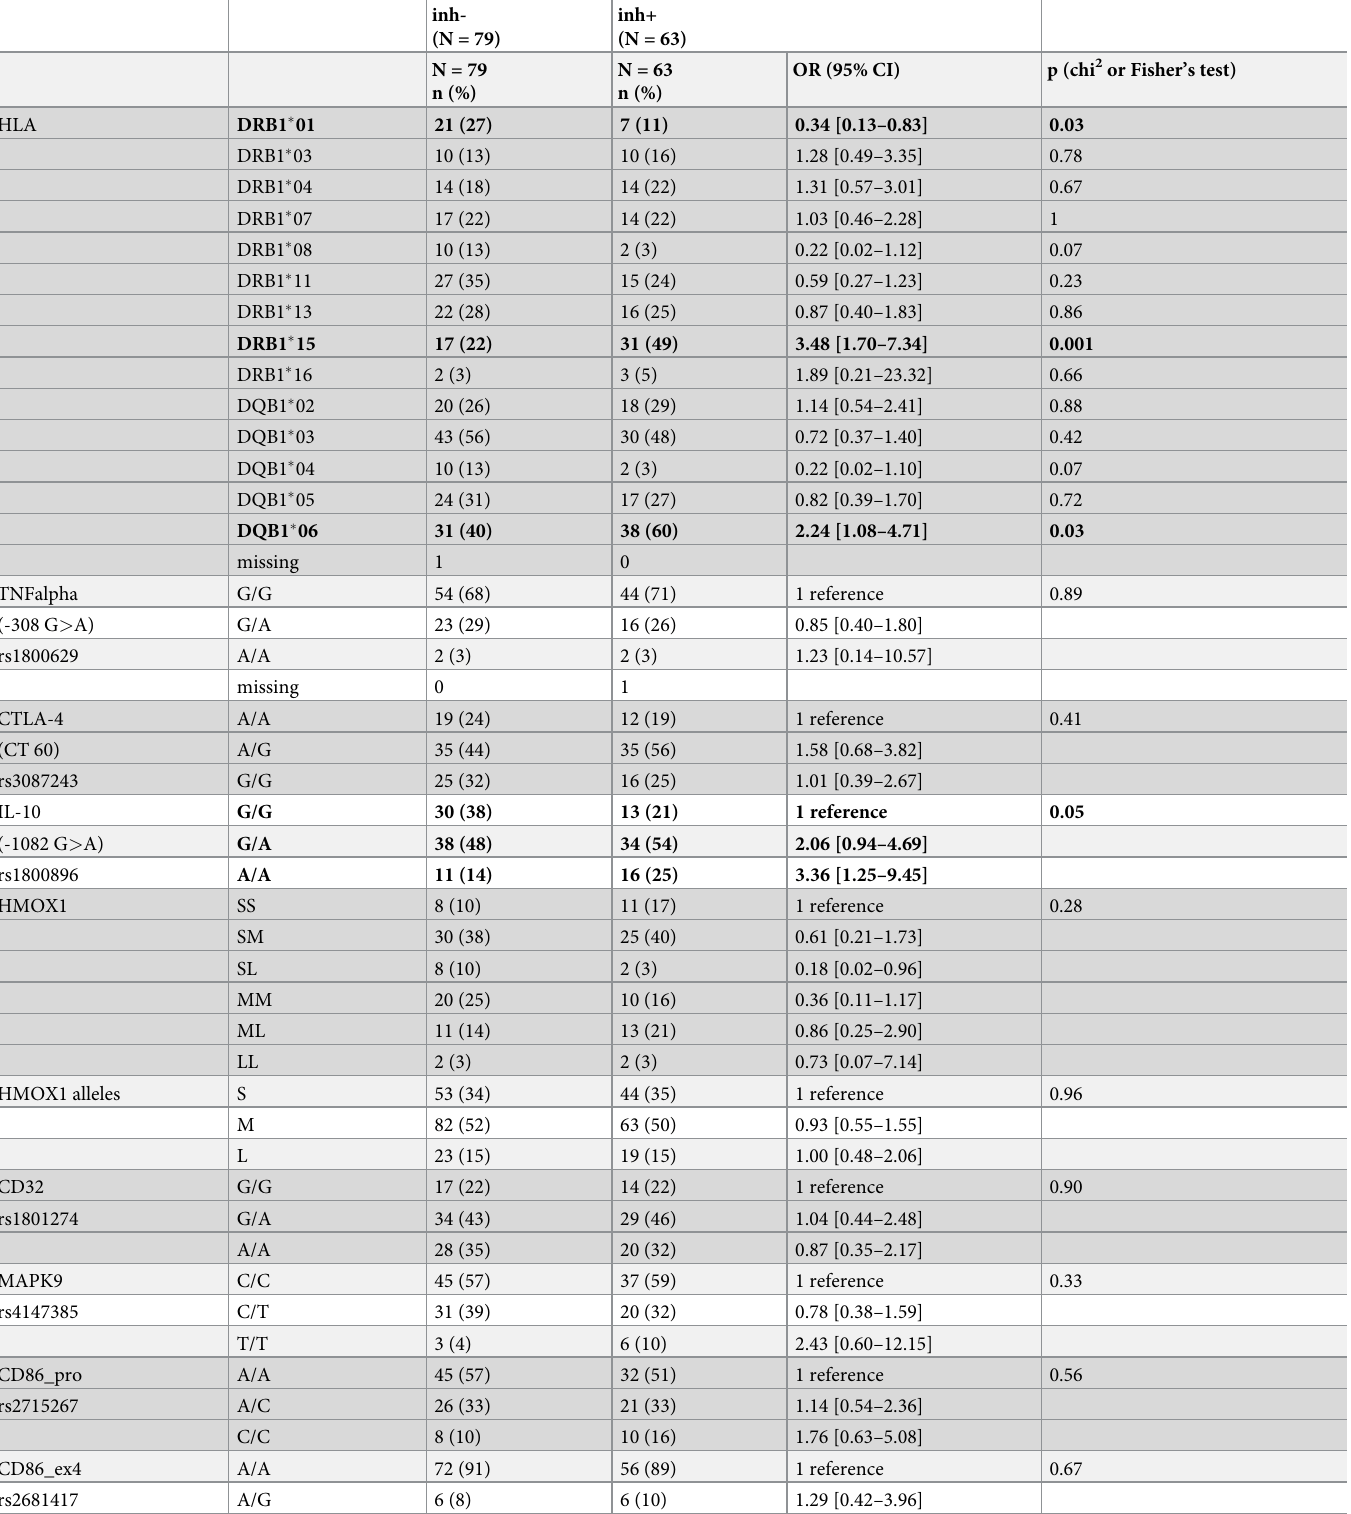
Table 3. Univariate odds ratios for genetic risk factors of inhibitor